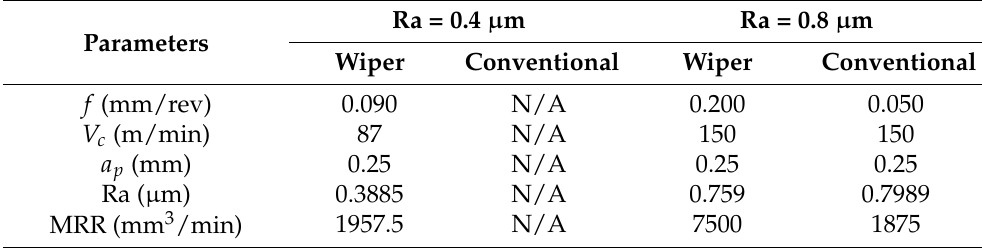
Table 10. The optimal running conditions for combustion chambers.